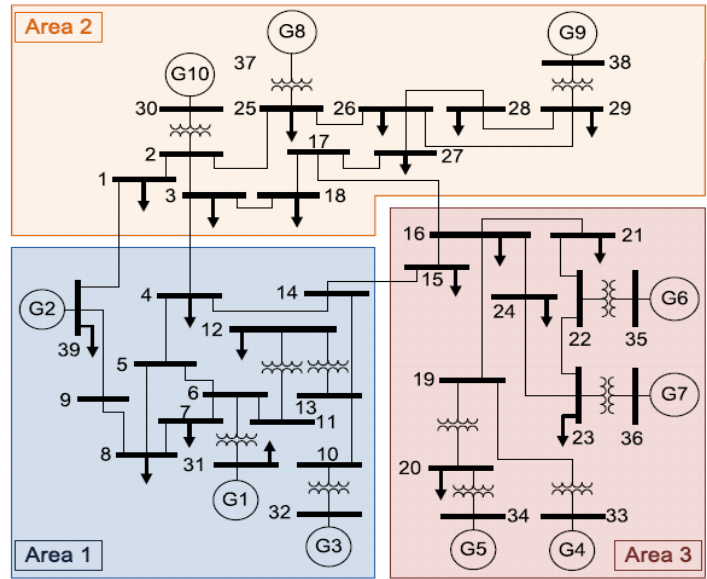
Figure 12. New England test system.